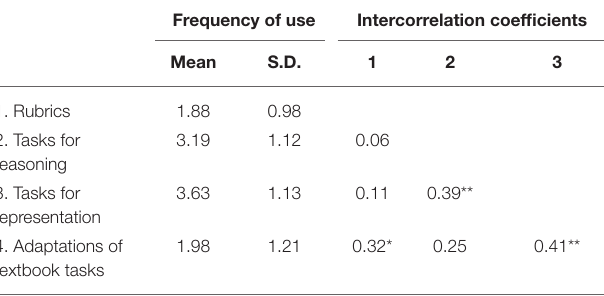
TABLE 2 | Mean and standard deviation and intercorrelation coefficients of how frequently all teachers implemented the four project objectives 5 months after the project (T3).